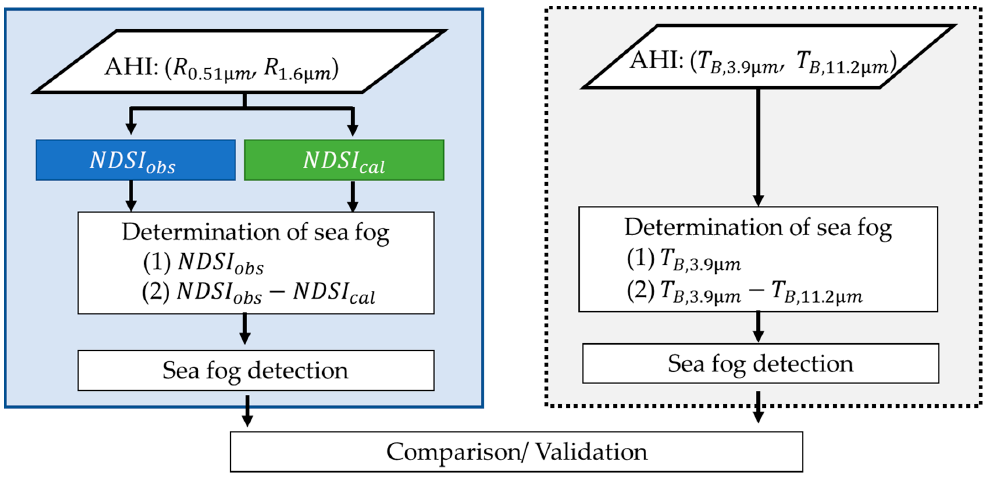
Figure 6. Flow chart of the proposed fog detection algorithm.